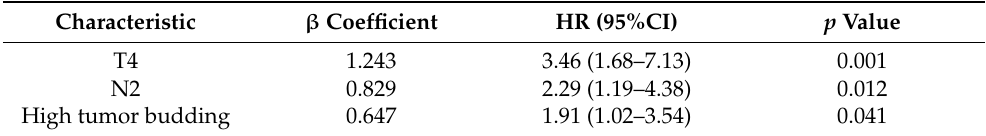
Table 2. Multivariate Cox Regression